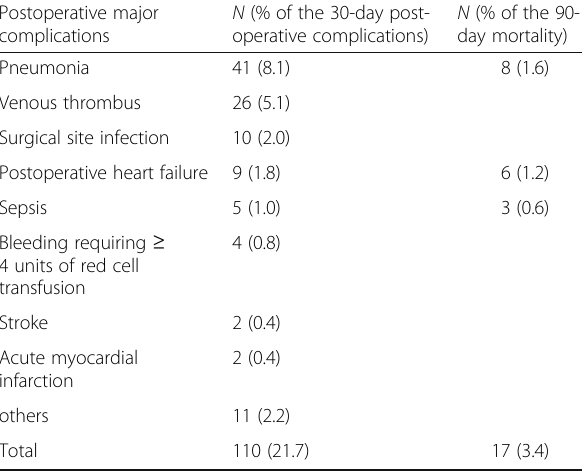
Table 4 Proportion of postoperative major complications Postoperative major